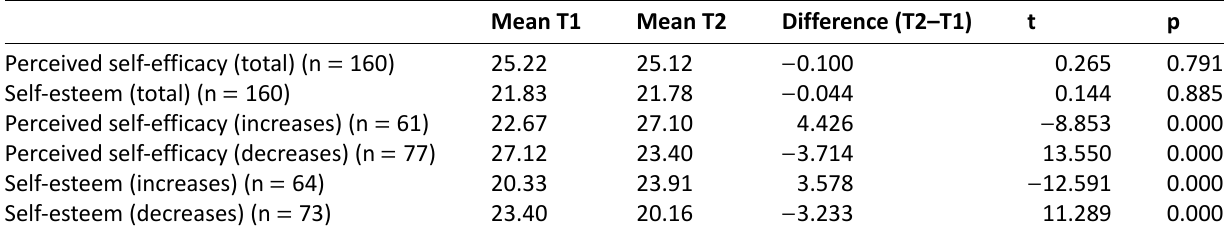
Figure 2. Self-esteem total at T1. Table 3. Developmental